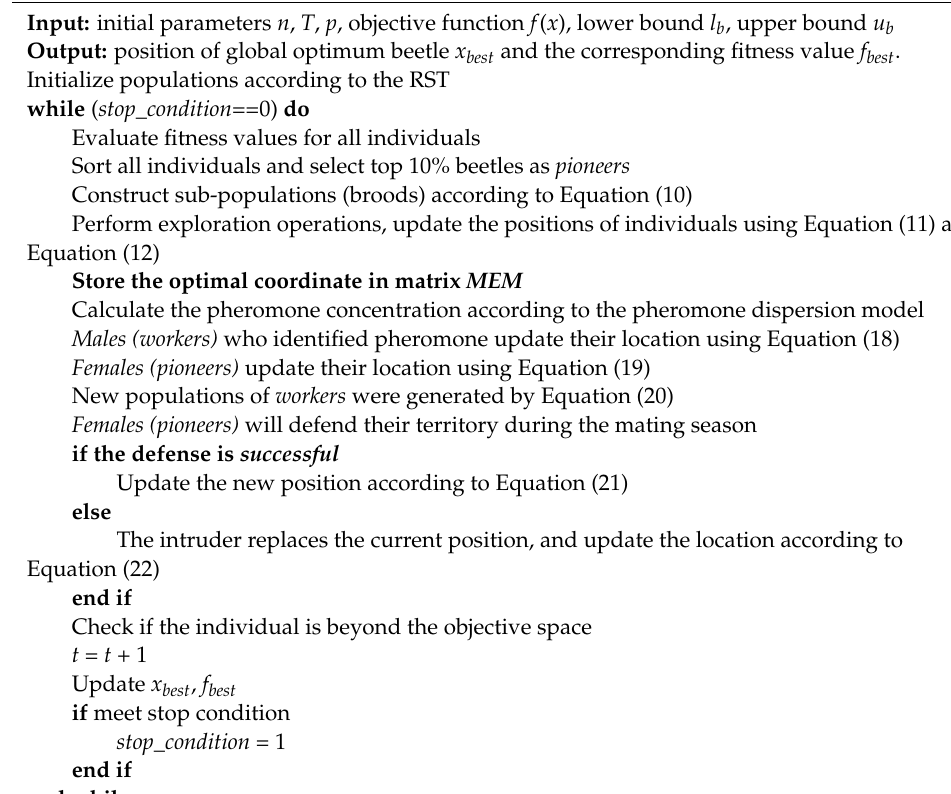
Algorithm 1: Pity Beetle Algorithm Based on Pheromone Dispersion